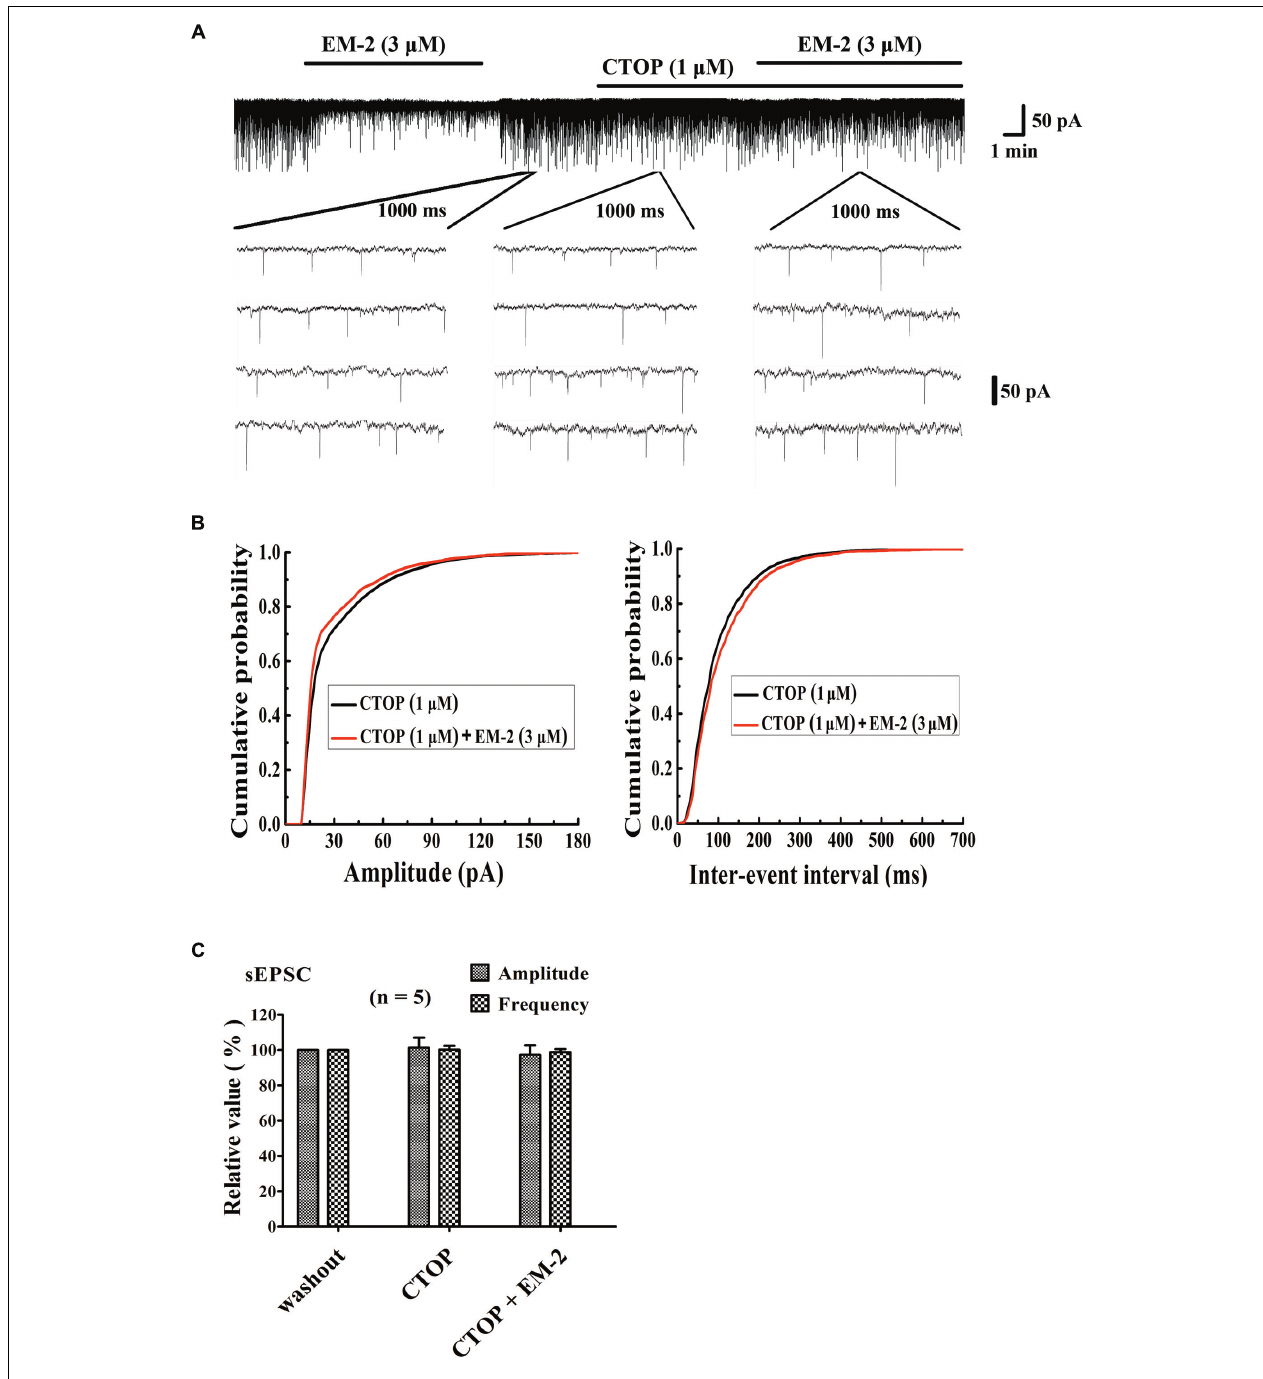
FIGURE 6 | CTOP blocked the action of EM-2 on sEPSCs in motoneurons. (A) A sample trace of sEPSCs in the presence and wash-out of EM-2 (3 µ M), and subsequently the presence of CTOP (1 µ M) and EM-2 (3 µ M) together with CTOP (1 µ M). (B) Cumulative distributions of the amplitudes (left) and inter-event intervals (right) of the sEPSCs in the presence of CTOP (black line) and EM-2 together with CTOP (red line). EM-2 did not significantly shift the mean cumulative distribution of the sEPSC amplitude or the inter-event intervals ( P > 0.05; Kolmogorov–Smirnov test). These data were obtained from the same neuron as in panel (A) . (C) Bar graph show the analytical results of three continuous recordings during which the wash-out of EM-2, presence of CTOP and EM-2 together with CTOP were treated in five ventral horn neurons. CTOP had no effect on either the amplitudes or frequency of sEPSCs ( P > 0.05), with perfusion of both CTOP and EM-2, EM-2 was unable to decrease the amplitudes or frequency of the sEPSCs ( P > 0.05). Holding potential = –70